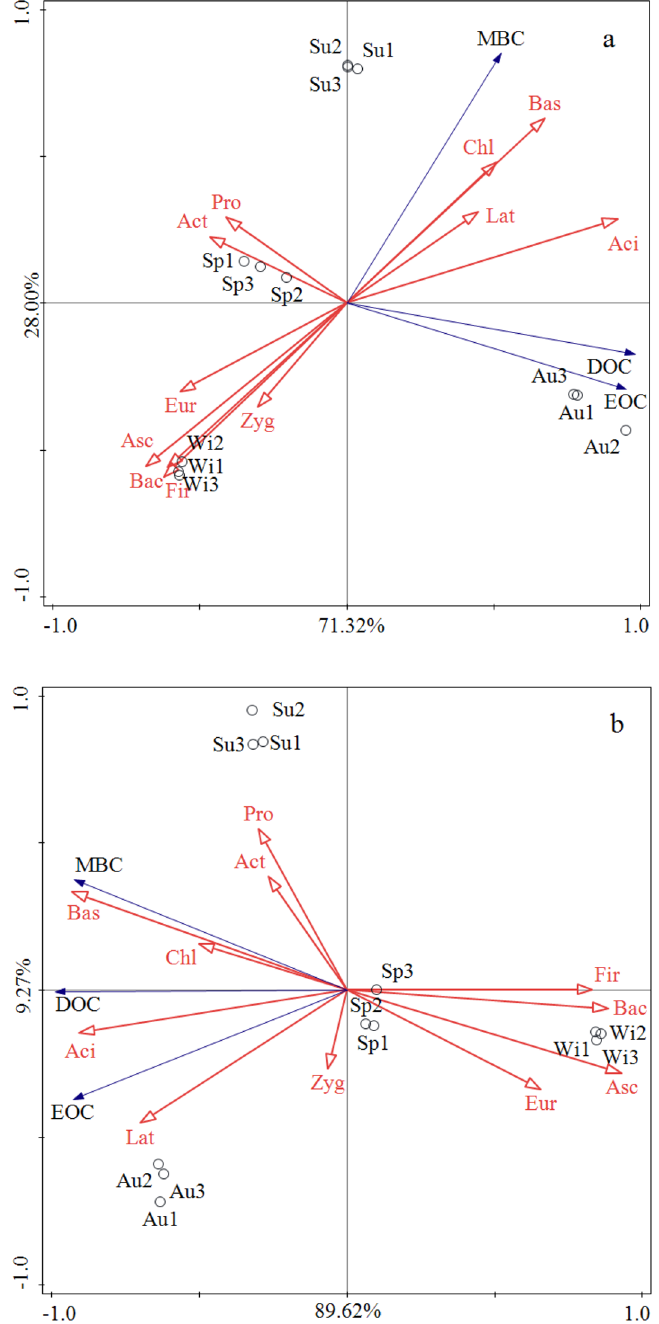
Figure 4. Ordination plots of the redundancy analysis (RDA) to identify the relationship between the abundance of microbial taxa (blue arrows) and LOC (red arrows). ( a ) The relationship between the soil microbial taxa and soil active organic carbon in Picea asperata Mast.; ( b ) the relationship between the soil microbial taxa and soil active organic carbon in Betula albosinensis . Sp, Su, Au and Wi represent spring, summer, autumn, and winter, respectively. The abbreviations of the microbial taxa are as follows: Aci: Acidobacteria ; Pro: Proteobacteria ; Bac: Bacteroidetes ; Fir: Firmicutes ; Act: Actinobacteria ; Lat: Latescibacteria ; Chl: Chloroflexi ; Eur: Euryarchaeota ; Bas: Basidiomycota ; and Asc: Ascomycota (this figure is made by Canoco, version 5.0, 2012, Microcomputer Power, Ithaca, NY, USA; software available at: http://www.canoc